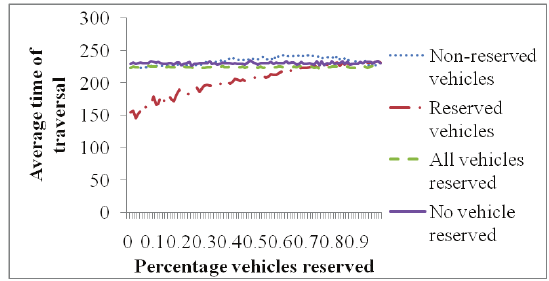
Fig. 8. Comparative analysis of lane reservation system for different percentage of vehicles